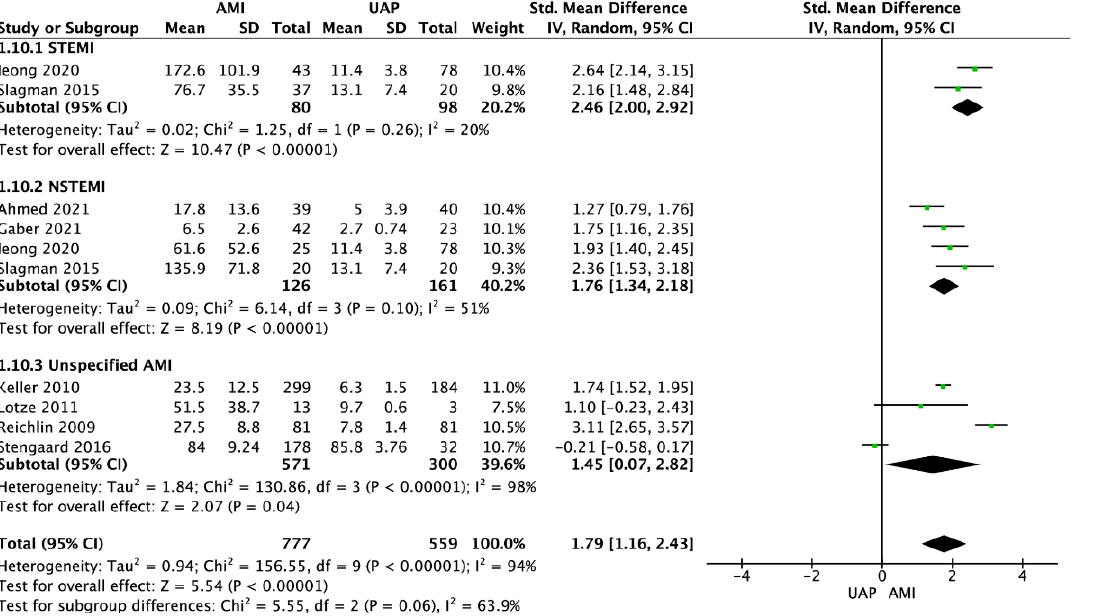
Figure 3. Forest plot of copeptin levels in the AMI and UAP groups. The center of each square represents the weighted standard mean difference for individual trials, and the corresponding horizontal line stands for a 95% confidence interval. The diamonds represent pooled results. Legend: CI = confidence interval; SMD = standard mean difference.